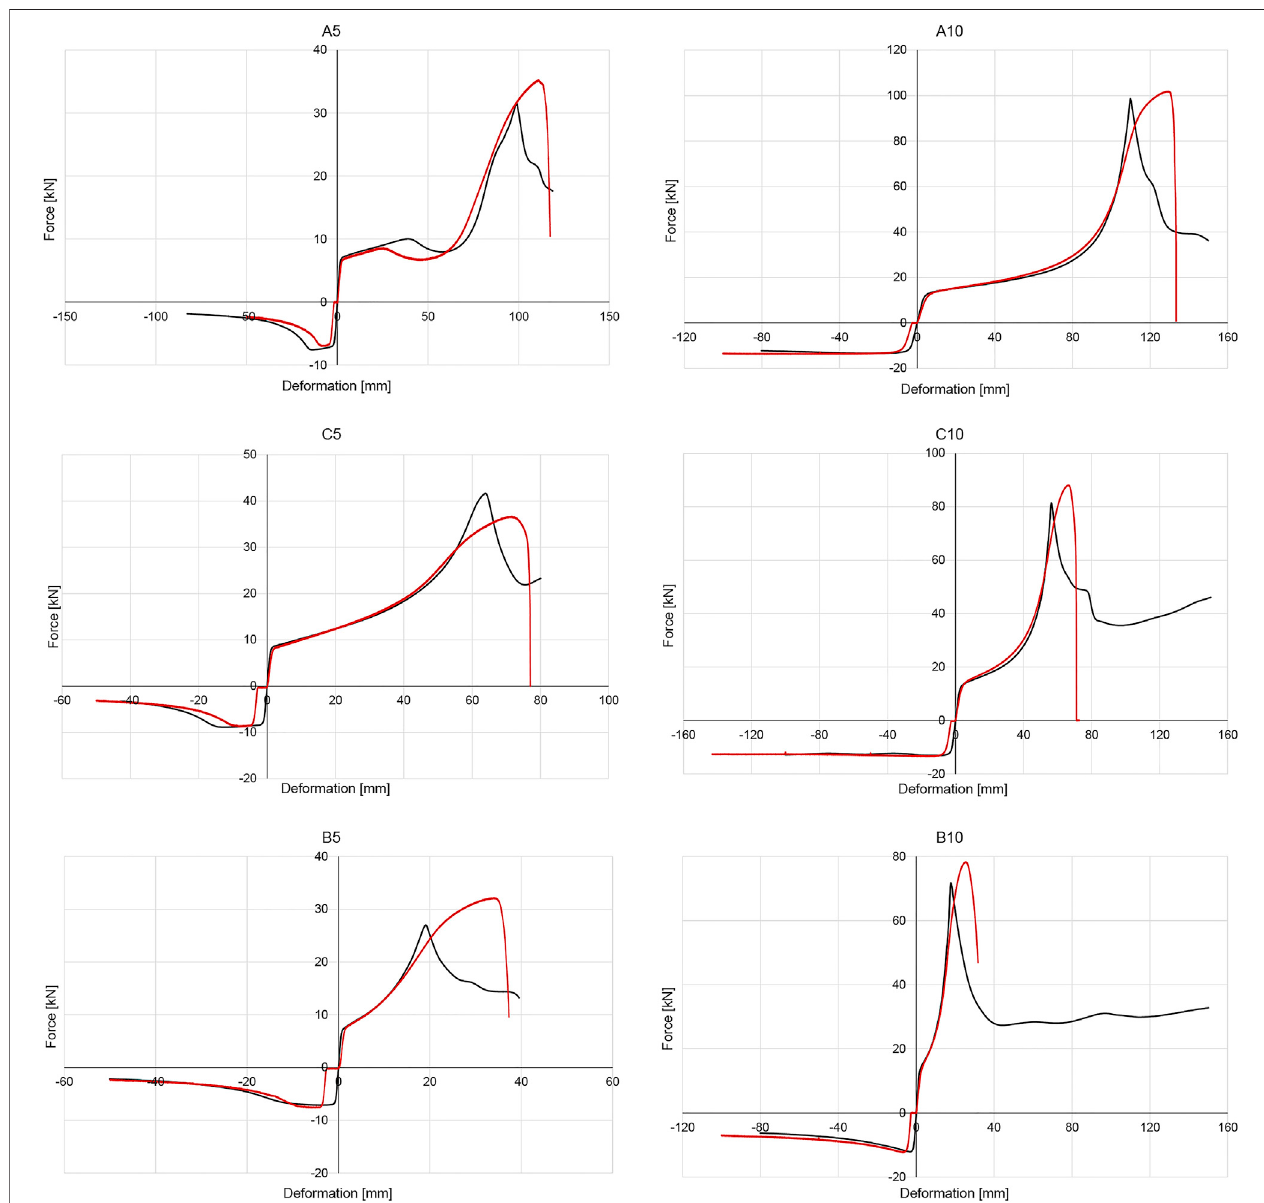
FIGURE 3 | Comparison between monotonic numerical results (black line) and experimental tests (red line).